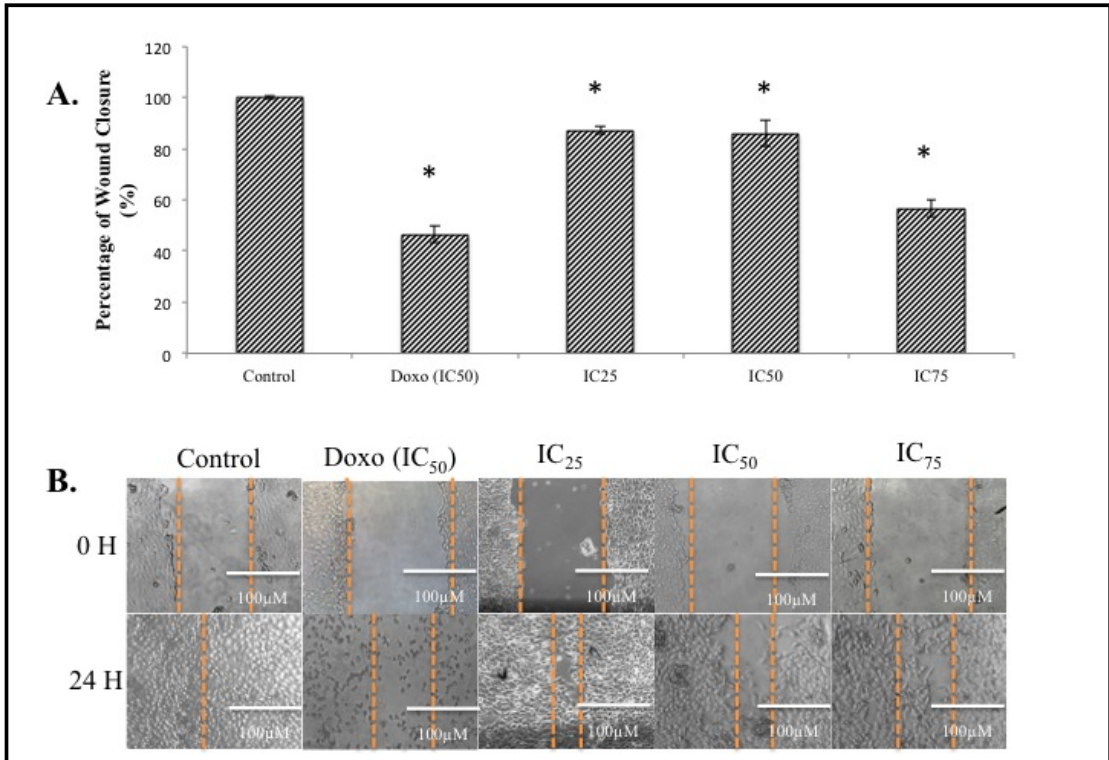
Figure 4. ( A ) The percentage of wound closure of MDA-MB231 cells when treated with BHAQ (IC , IC and IC ) and doxorubicin (IC ) after 24 h. ( B ) Figures of the wound at 25 50 75 50 0 h and 24 h post-treatment. All data are expressed as mean ± SD. * p < 0.05 compared with corresponding controls (magnification: